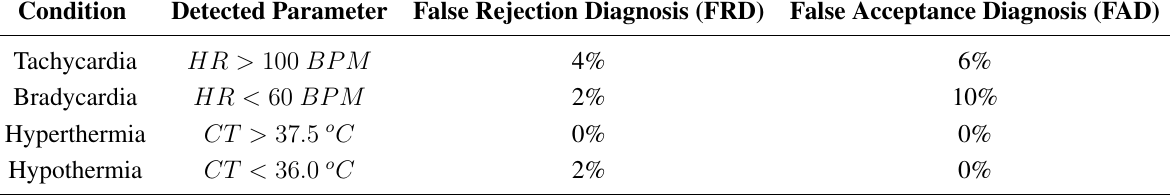
Table 6. Comparative test between the diagnostics provided by the SMTRPM and the nurses. Condition Detected